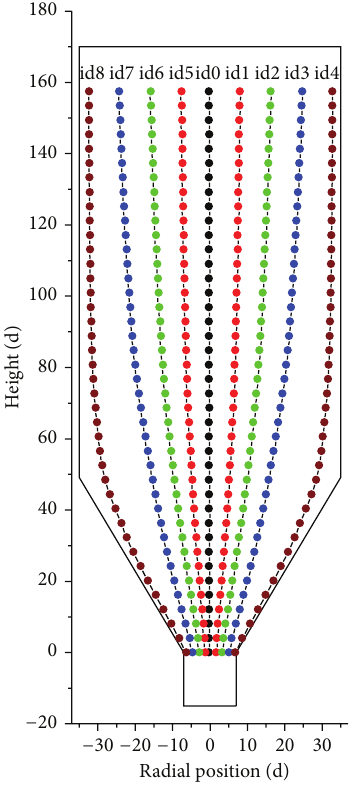
Figure 7: Distribution of the mean stagnant time and streamline of the marking pebbles in the experiment ( ℎ = 160